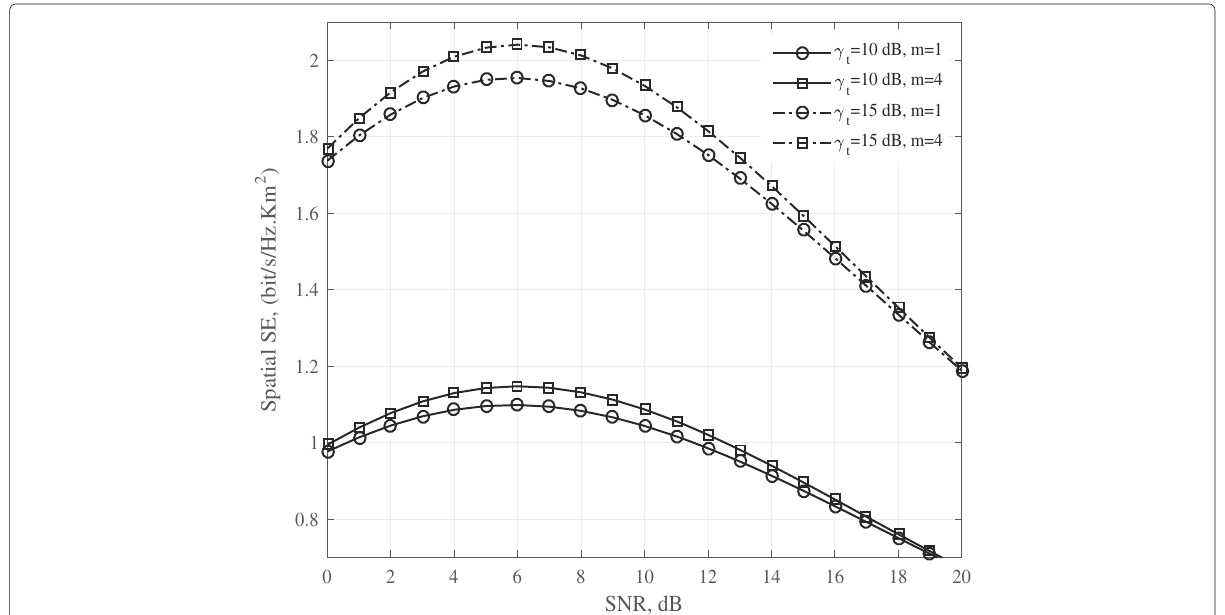
Fig. 9 Spatial spectral efficiency in (bit/s/Hz km 2 ) for single cell as a function of SNR for fading figure m = 1 and 4, SNR threshold γ t = 10 and 15, and path loss exponent α = 4. Spatial SE for, m = 1 and 4, and γ t = 10 and